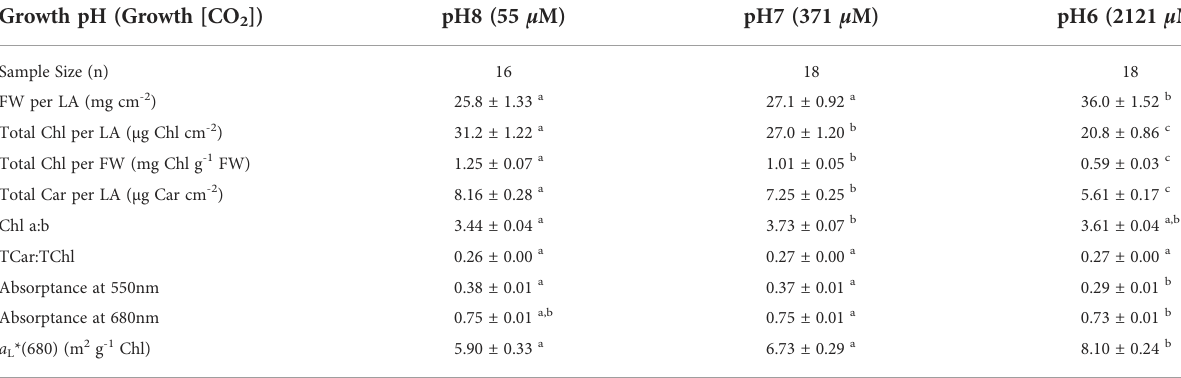
TABLE 3 Pigment content and optical properties of leaves used in photosynthesis measurements. Growth pH (Growth [CO 2